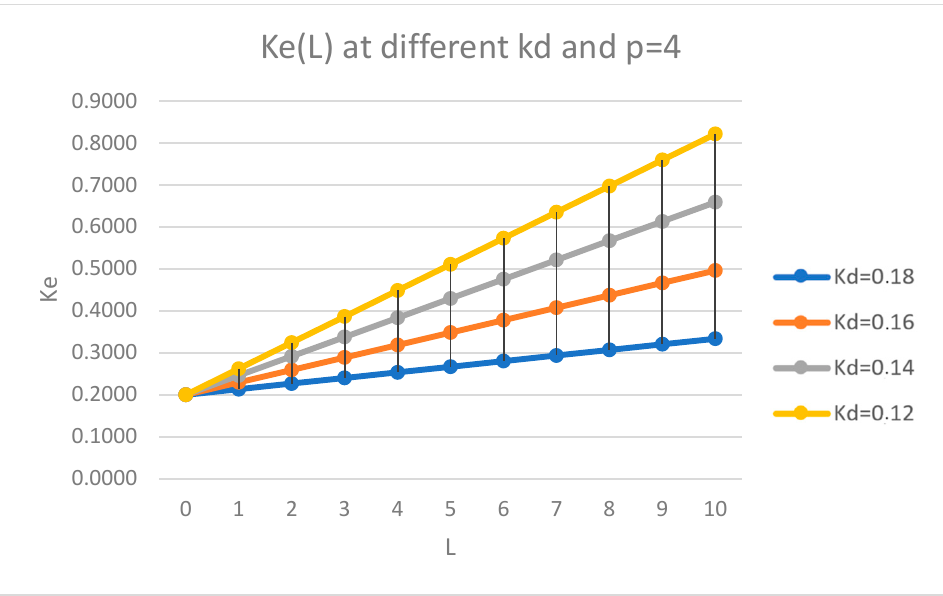
Figure 19. Dependence of the equity cost, k e , on leverage level L at different debt cost k d (12%; 14%; 16%; 18%) and fixed frequency of payments of tax on profit p = 4.